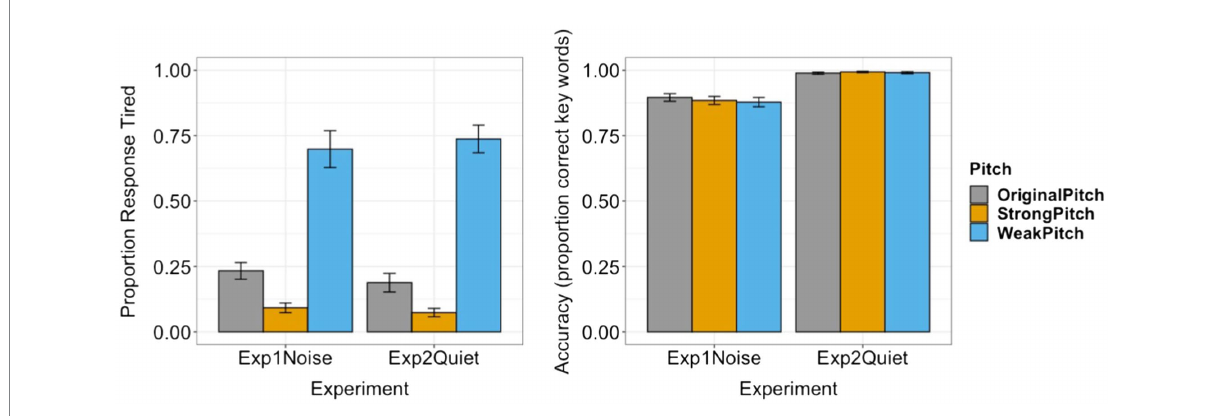
FIGURE 2 Behavioral data of tiredness judgment (left panel) and speech recognition (right panel). Error bars: ± standard